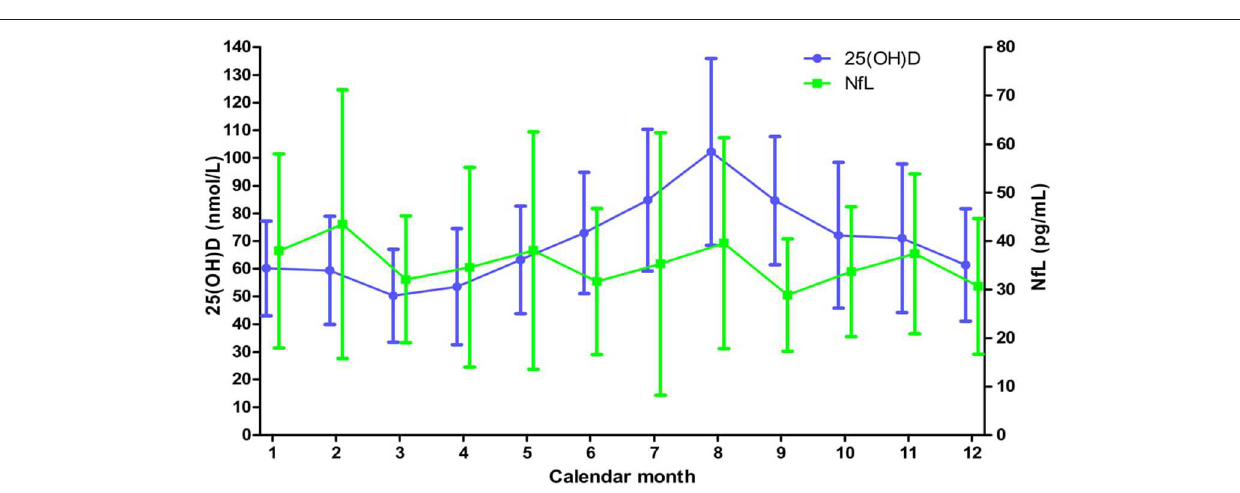
FIGURE 2 | Mean (SD) serum levels of 25(OH)D and NfL levels throughout the calendar year for the whole study. Based on all available 25(OH)D and NfL measurements from a minimum of 41 and 16 patients, respectively, at each month.